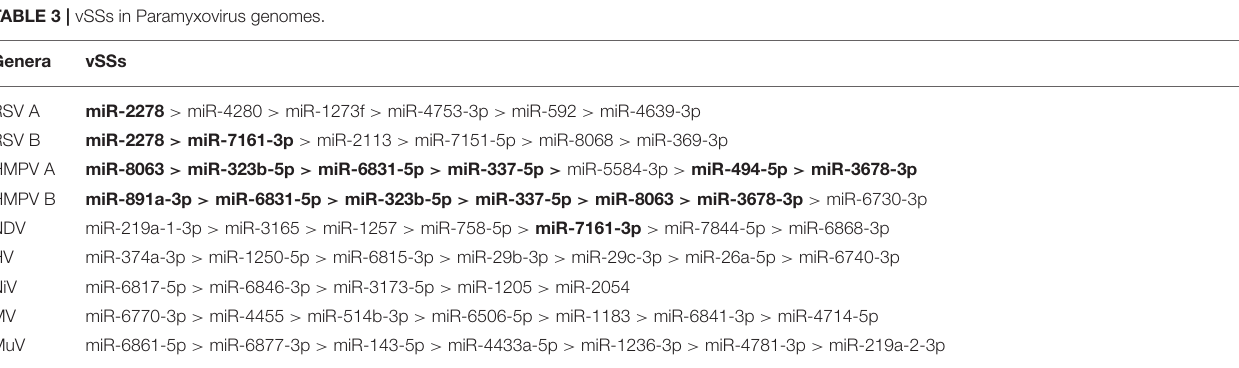
TABLE 3 | vSSs in Paramyxovirus genomes.